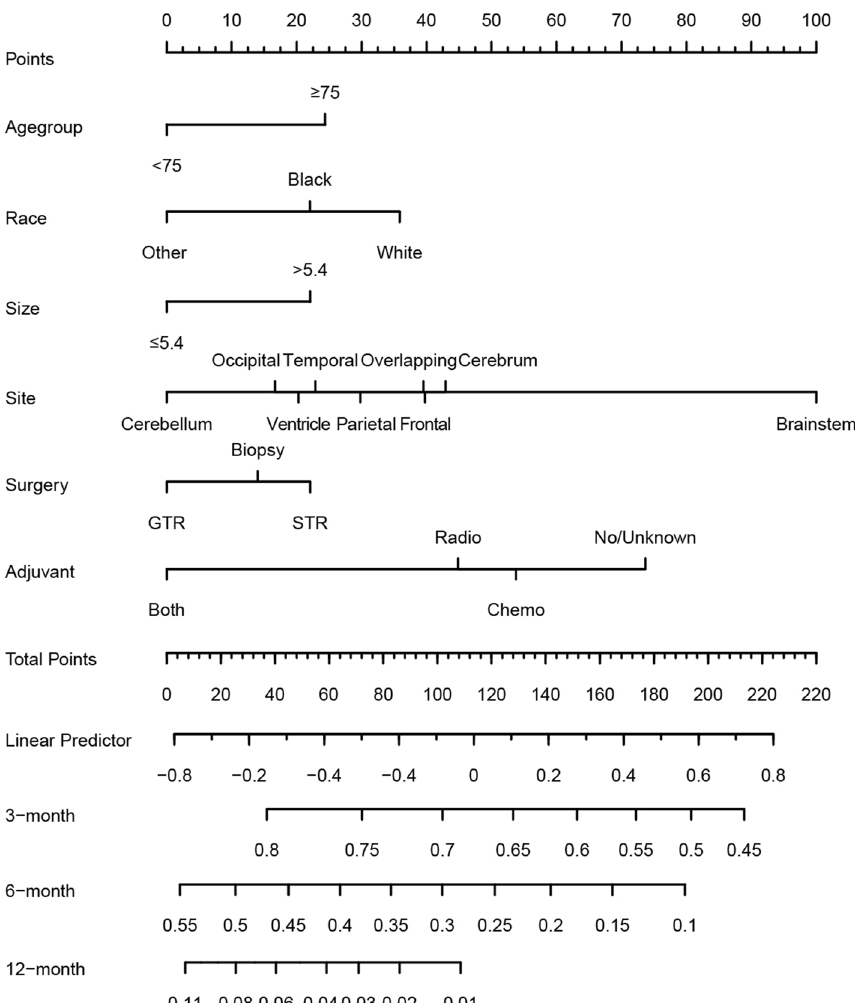
Figure 3. Competing risk nomogram to predict 3-, 6-, and 12-month GBM related mortality of the elderly patients with